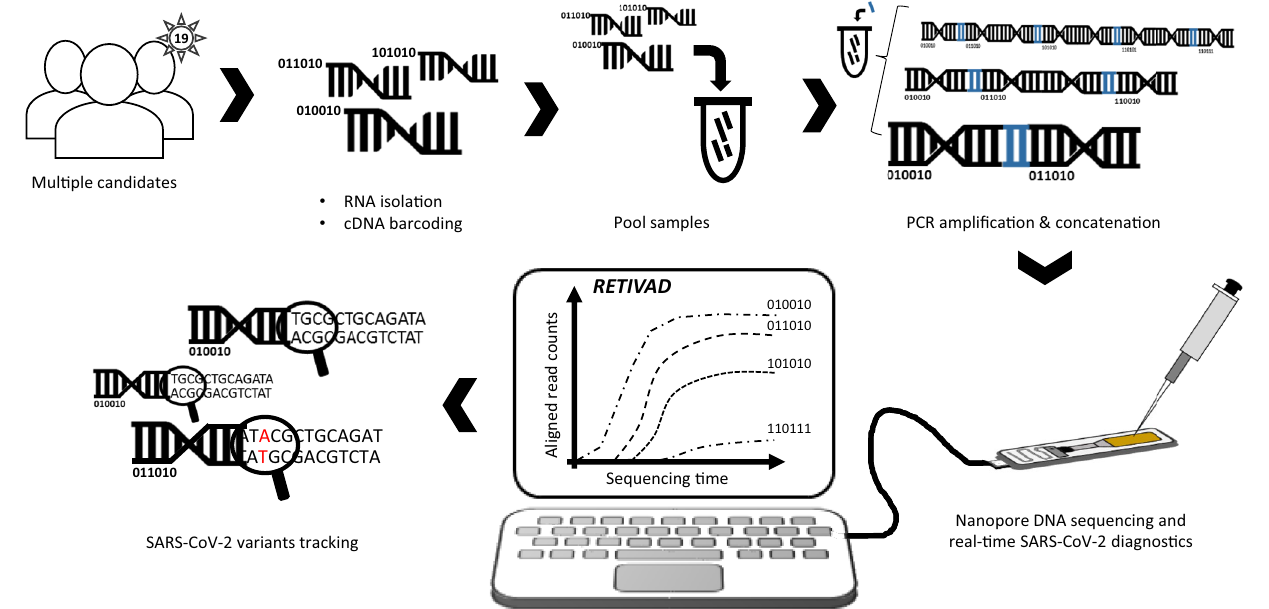
Figure 1. Scheme illustrating the proposed real-time SARS-CoV-2 diagnostics and variants tracking strategy. RNA samples isolated from multiple candidates are converted into complementary DNA (cDNA) such that samples associated to each candidate are labelled by molecular DNA barcodes appended to their extremities. Barcoded-cDNA samples are pooled together and PCR amplified in presence of a bridge sequence